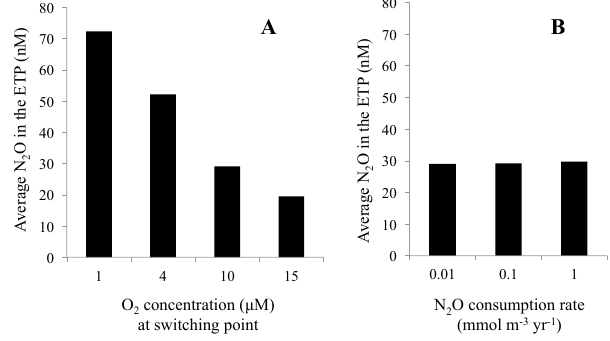
Fig. 6. Sensitivity of average modelled N 2 O concentrations in the Eastern Tropical Pacific (ETP) between 80-150 ◦ W, 23.5 ◦ N–23.5 ◦ S, and 150–2000m to (a) the O 2 concentration at which N 2 O consumption begins (assuming an N 2 O consump- tion rate of 0.129mmolm − 3 yr − 1 ), and (b) N 2 O consumption rate (mmolm − 3 yr − 1 ) (assuming a switching point of 10mmol O 2 m − 3